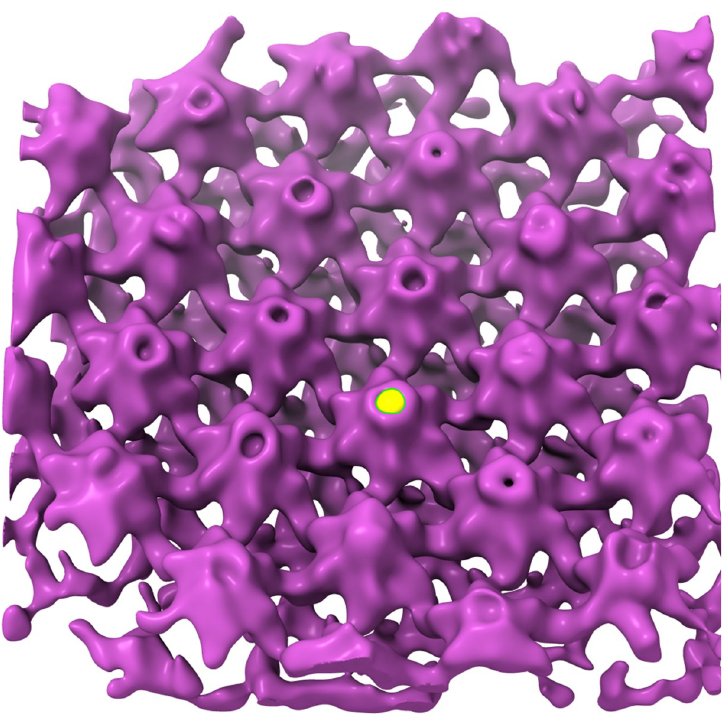
Fig 3. Center of unit cell defined in Chimera UCSF. The center of a unit cell (yellow dot) was marked by first rotating the average upside down and then marking the tip of the CA-N terminal domain using the volume tracer